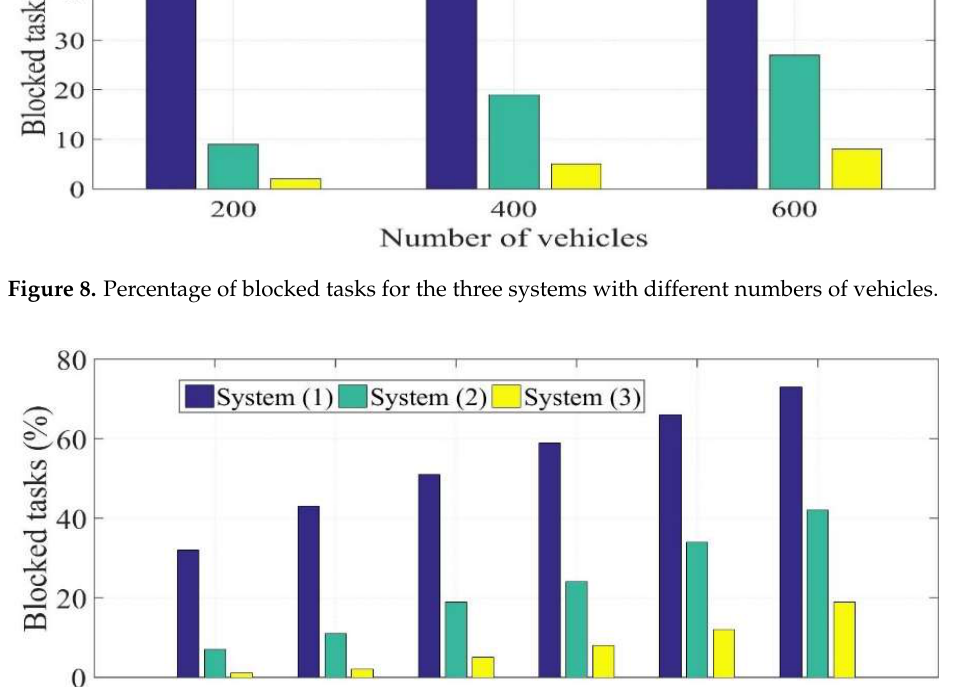
Figure 10. Percentage of blocked tasks for the three systems at different traffic densities. Table 2. Statistical analysis of simulation results of the three systems introduced in Figures 8–10.